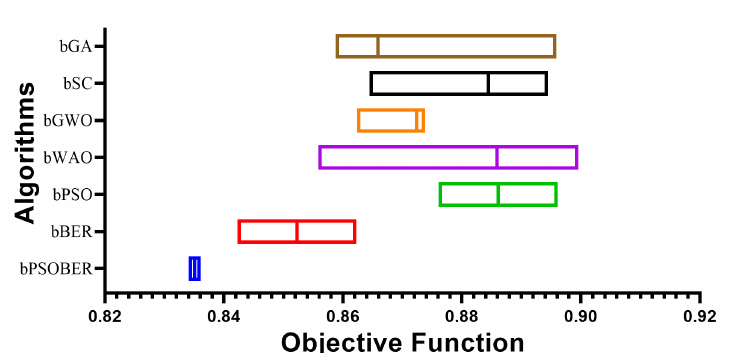
Figure 11. The average error of the results achieved based on the proposed feature selection algorithm,